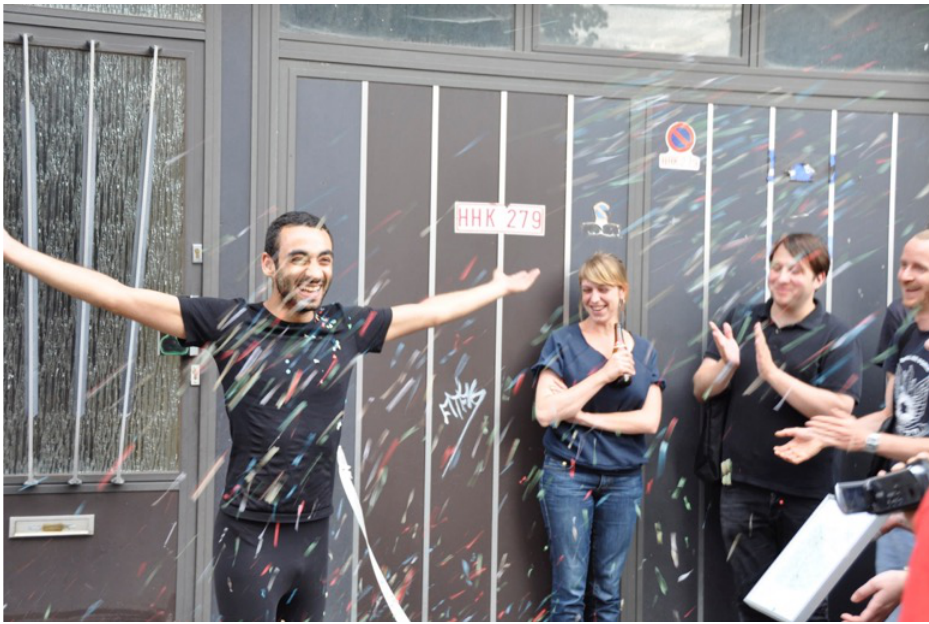
Mehdi-Georges Lahlou, Walking 30km with red high heel shoes between 2 art spaces (detail), 2009. From Galerie Transit, Mechelen to Lokaal 01, Antwerp, Belgium. 9-hour performance. Image courtesy of the artist and Galerie Transit, Mechelen, Belgium. (photo: Bert de